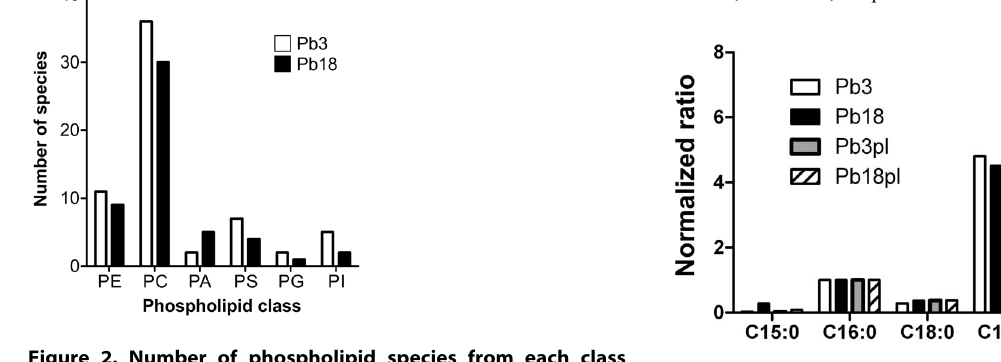
Figure 3. GC-MS analysis of cell wall phospholipid fatty acids from Pb3 and Pb18 cultivated in the presence (pl) or absence of plasma. Fatty acid abundance was normalized to the C16:0 peak area.